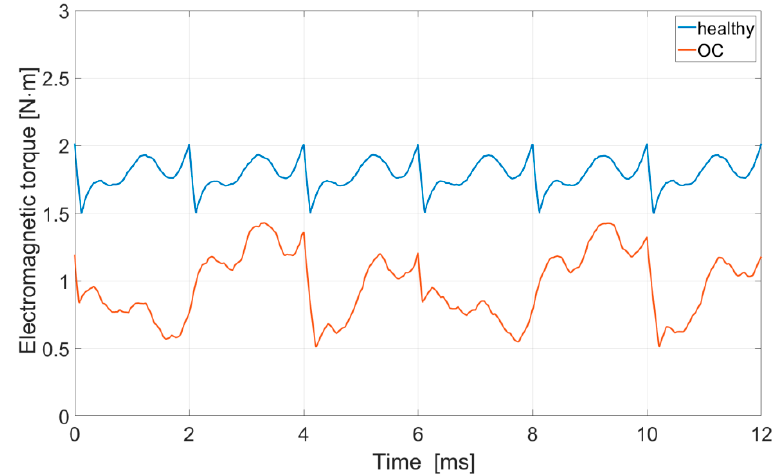
Figure 12. Delta ( Δ ) configuration—waveforms of electromagnetic torque.